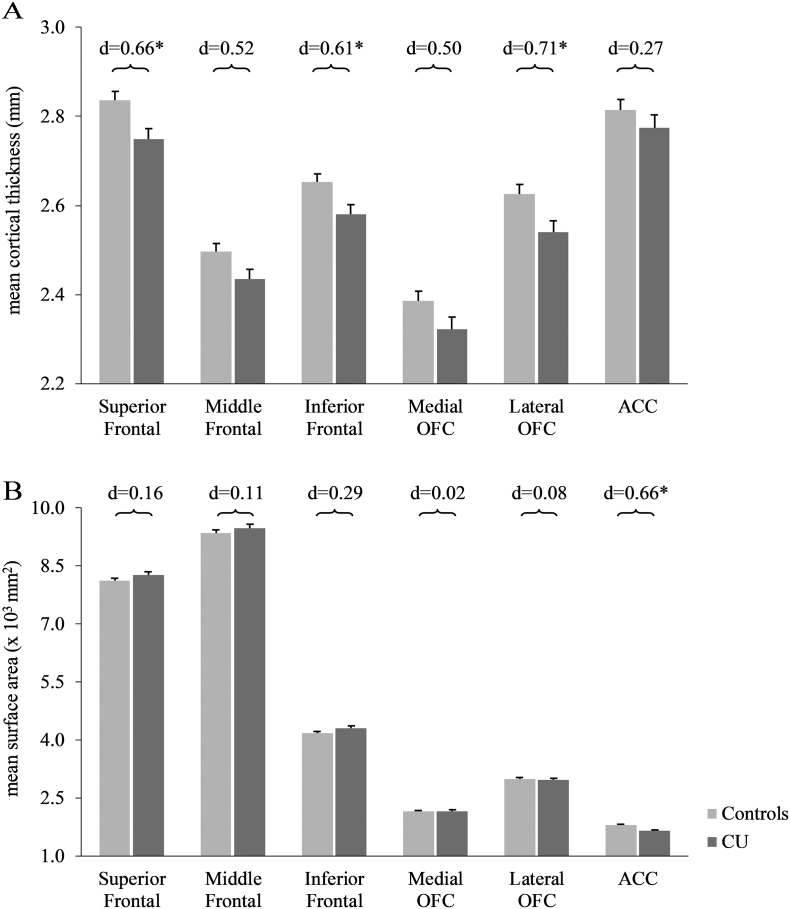
Cortical group differences at baseline.Group differences for cortical measures for the six regions of interest. (A) Mean cortical thickness (in mm) and standard errors. All values corrected for age, verbal IQ, and ADHD-SR score. (B) Mean cortical surface area (×103 in mm2) and standard errors. All values corrected for age, verbal IQ, ADHD-SR score, and total surface area.*P < .05 corrected for multiple comparisons. Cohen's d controls vs. cocaine users.